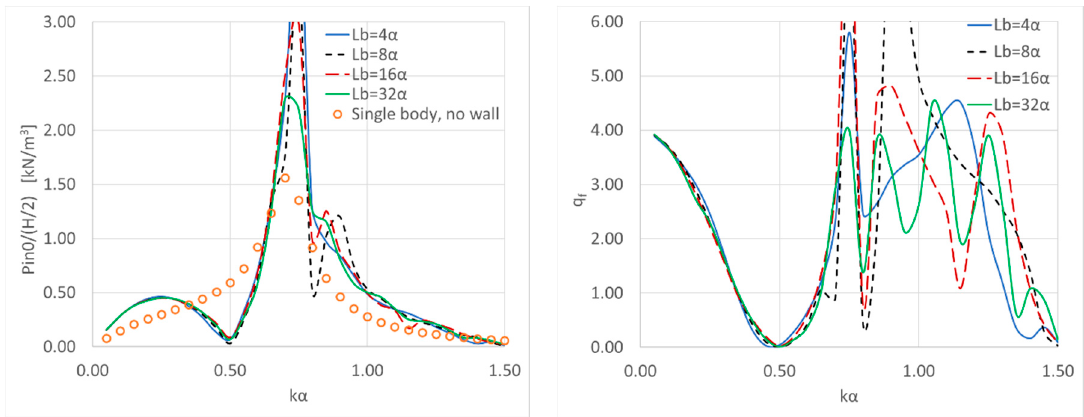
Figure 9. Air pressure inside the 1st OWC (left column figure) and array’s q f factor (right column figure) versus k α for various examined distances between the bodies. Here, β = 0.